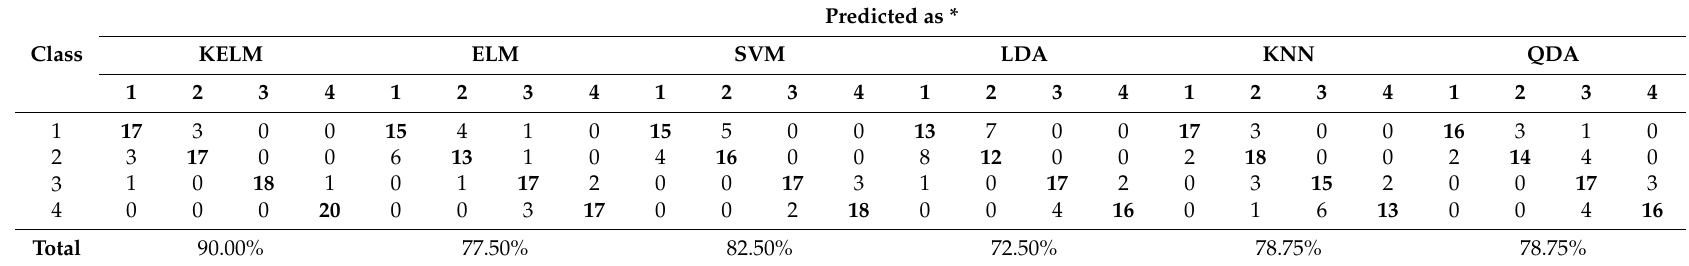
Table 2. Classification results of integral